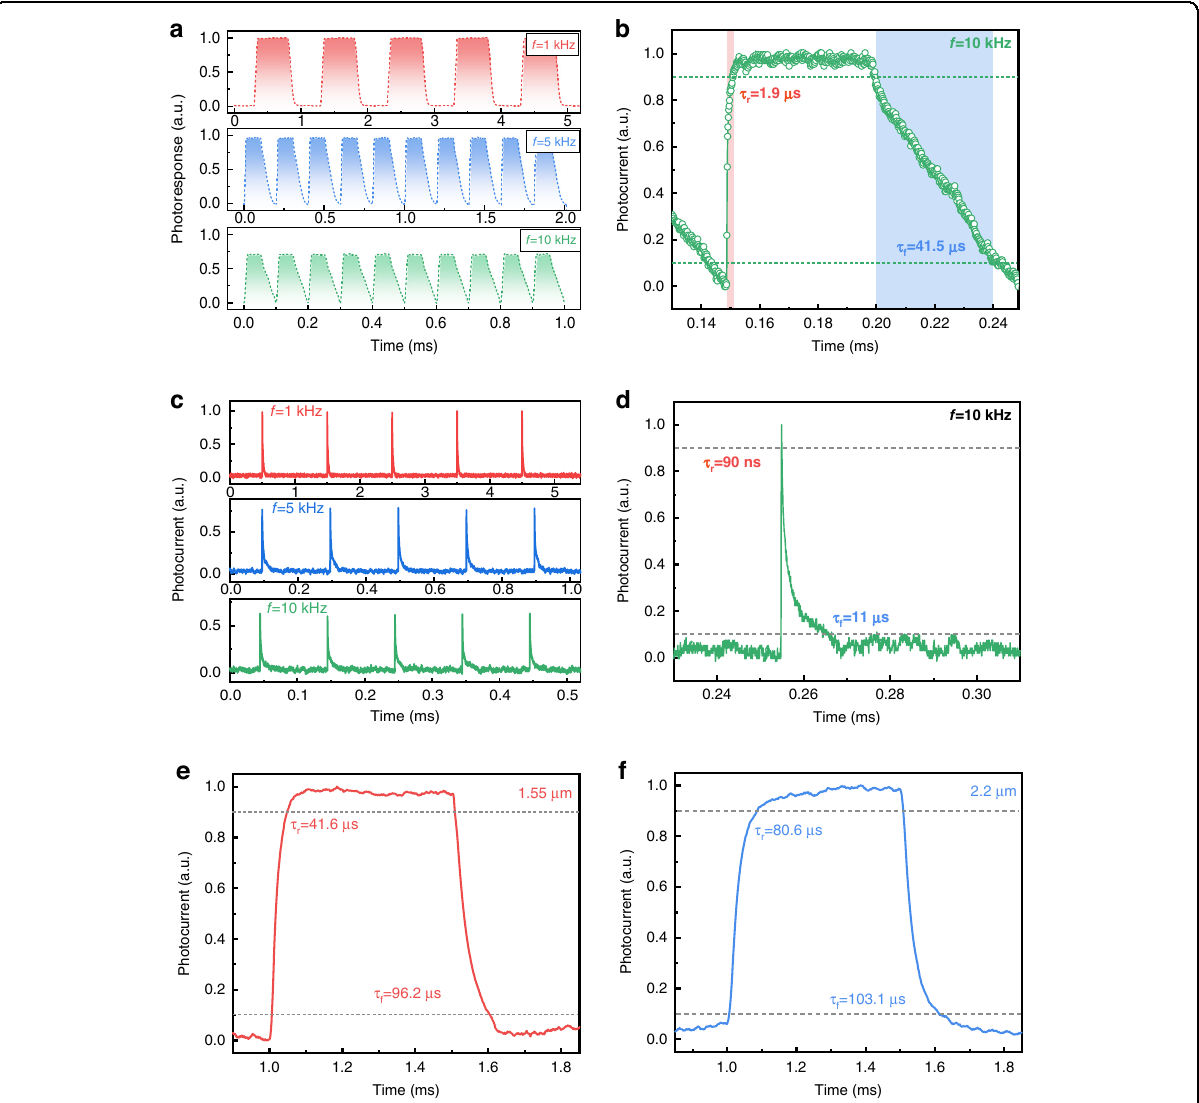
Fig. 5 Response speed of the photodetector. a Photoresponse properties of the photodetector to 980 nm pulse signals with a duty ratio of 50%. b Rising and falling time at 10 kHz with a duty ratio of 50%. c Photoresponse properties of the device to 980 nm pulse signals with a duty ratio of 0.1%. d Rising and falling time at 10 kHz with a duty ratio of 0.1%. Response speeds of the device at e 1.55 and f 2.2 μ m,